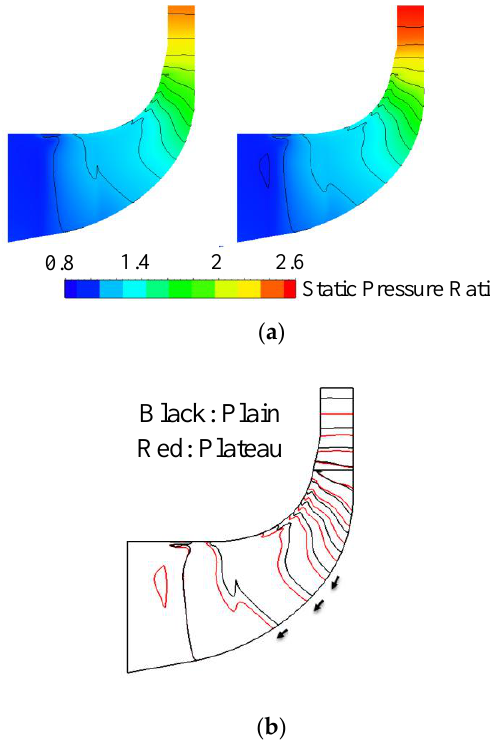
Figure 8. Static pressure ratio distribution on the meridional averaged surface: ( a ) left : plain, right : plateau; ( b ) contour lines superposition graph.